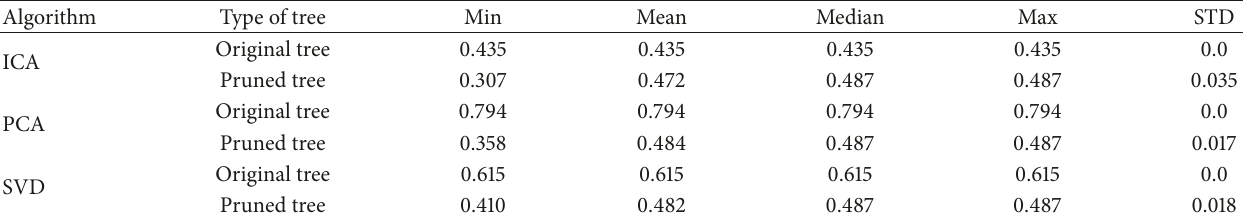
Table 1: Statistics of 51 runs of the reduced error pruning of the CART with 10-fold cross-validation with ICA, PCA, and SVD data reduction